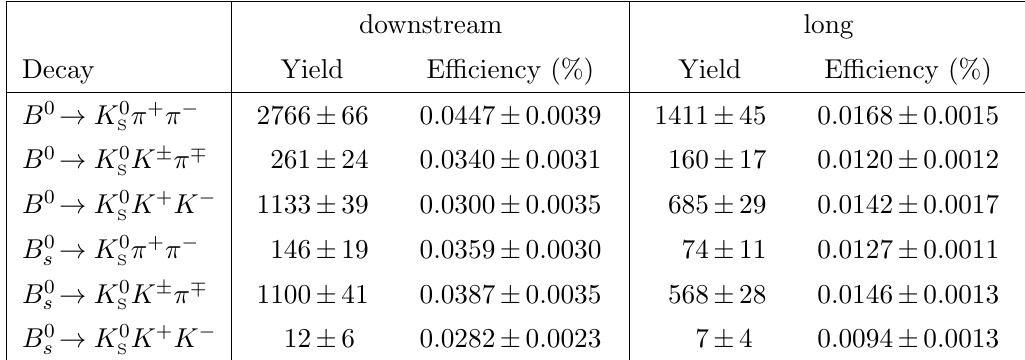
Table 1 . Signal yields obtained from the simultaneous (cid:12)t to the data. The yields are the sum of those obtained in the three data-taking periods when (cid:12)tting the data sample selected using the BDT optimisation chosen for the given decay mode. The uncertainties are statistical only. The average selection e(cid:14)ciencies, described in section 5, are also shown for each decay mode together with the corresponding total uncertainty due to the limited simulation sample size and systematic e(cid:11)ects in their